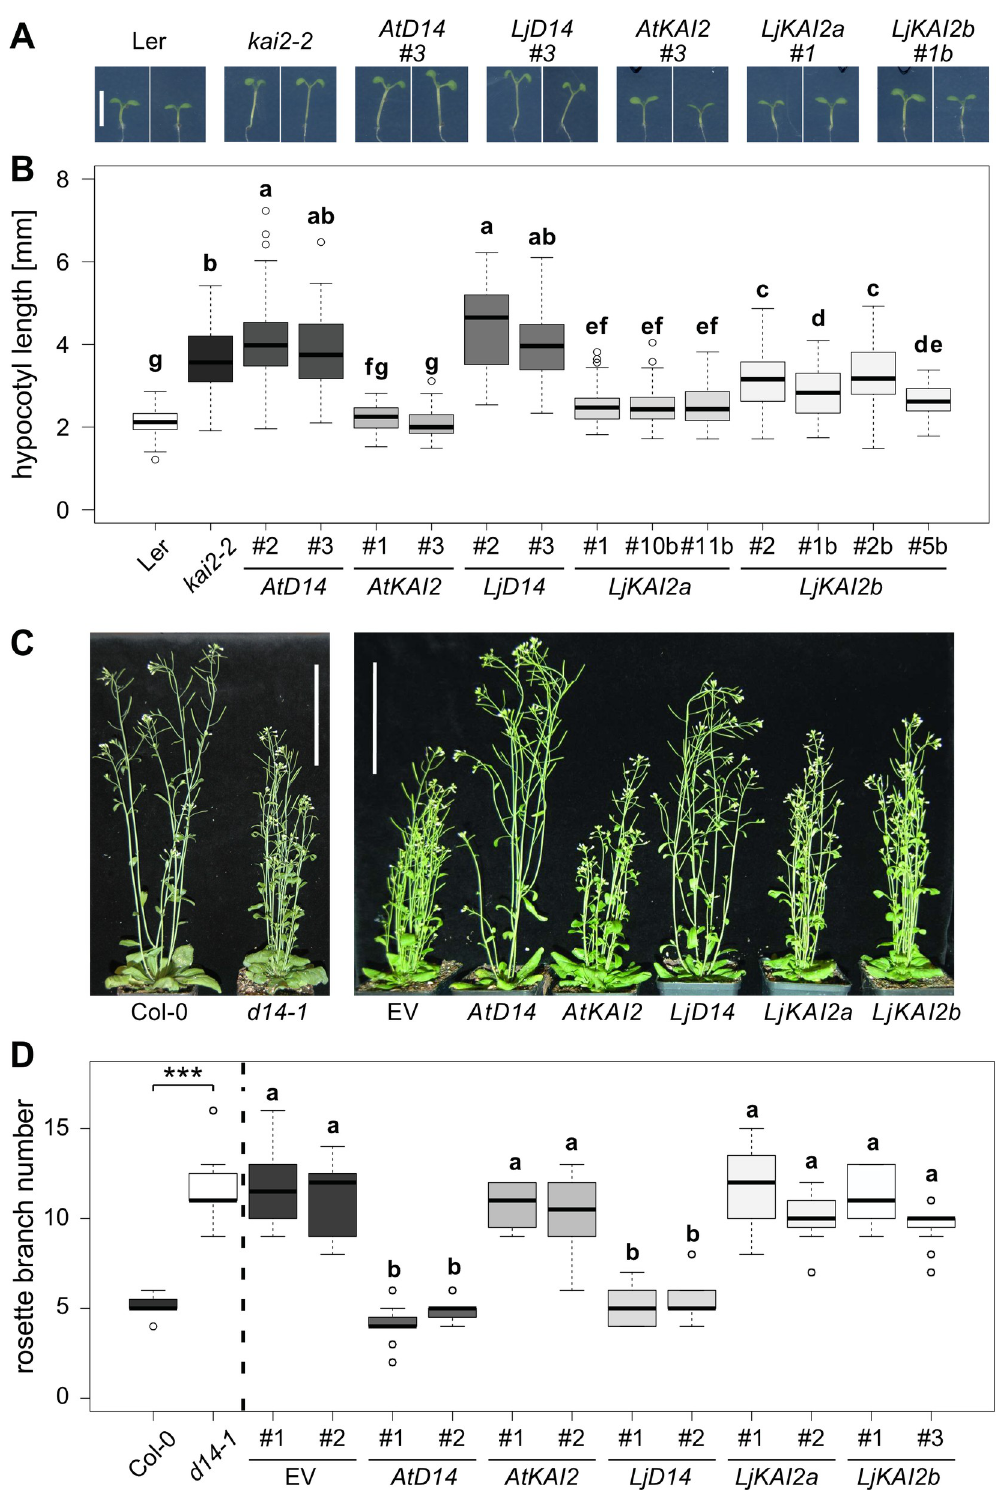
Fig 2. Lotus japonicus D14 , KAI2a and KAI2b can replace D14 and KAI2 in Arabidopsis, respectively. ( A-B ) Hypocotyl length of A . thaliana wild-type (L er ), kai2-2 and kai2-2 lines complemented by AtD14 , AtKAI2 , LjD14 , LjKAI2a and LjKAI2b , driven by the AtKAI2 promoter at 6 days post germination (dpg). Seedlings were grown in 16h light/8h dark periods (n = 37–122). Scale bar = 5mm. ( C ) Shoots of A . thaliana Col-0 and d14-1 , d14-1 , with an empty vector (EV)